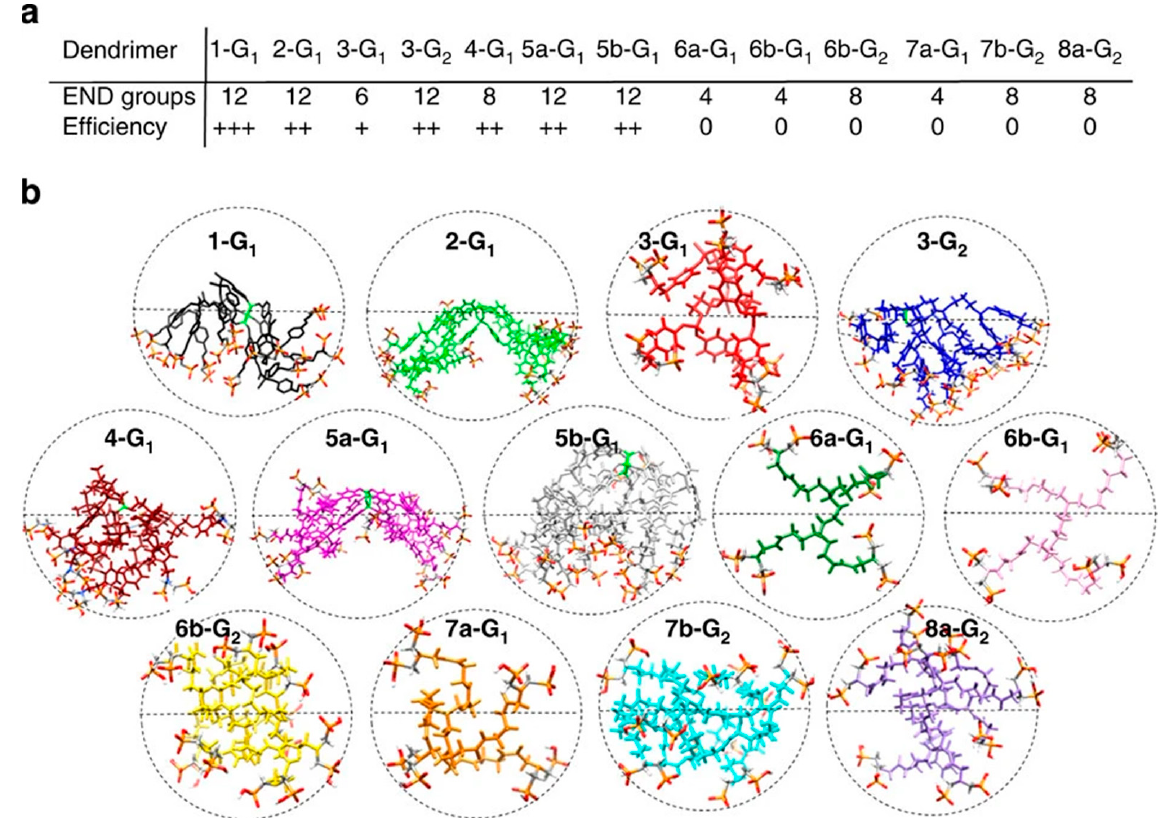
Figure 5. Equilibrated configurations of seven families of dendrimers—PAMAM (7a,b-Gn), PPI (6a,b-Gn), carbosilane dendrimers (4-G1), PLL (8a-G2) and phosphorus-containing dendrimers (1-G1, 2-G1,3-Gn, 5a,b-G1) bearing azabisphosphonate (ABP) groups at their surface obtained by molecular dynamics simulations. ( a ) Bioactivity of dendrimers to alternatively activate human monocytes in vitro in function of the number of ABP groups (END groups). Efficiency of activation of monocytes from 0 (no activation) to +++ (the highest activation). ( b ) Equilibrated MD configurations of different den- drimers. Adapted from Caminade et al. [185] (licensed under CC BY 4.0).